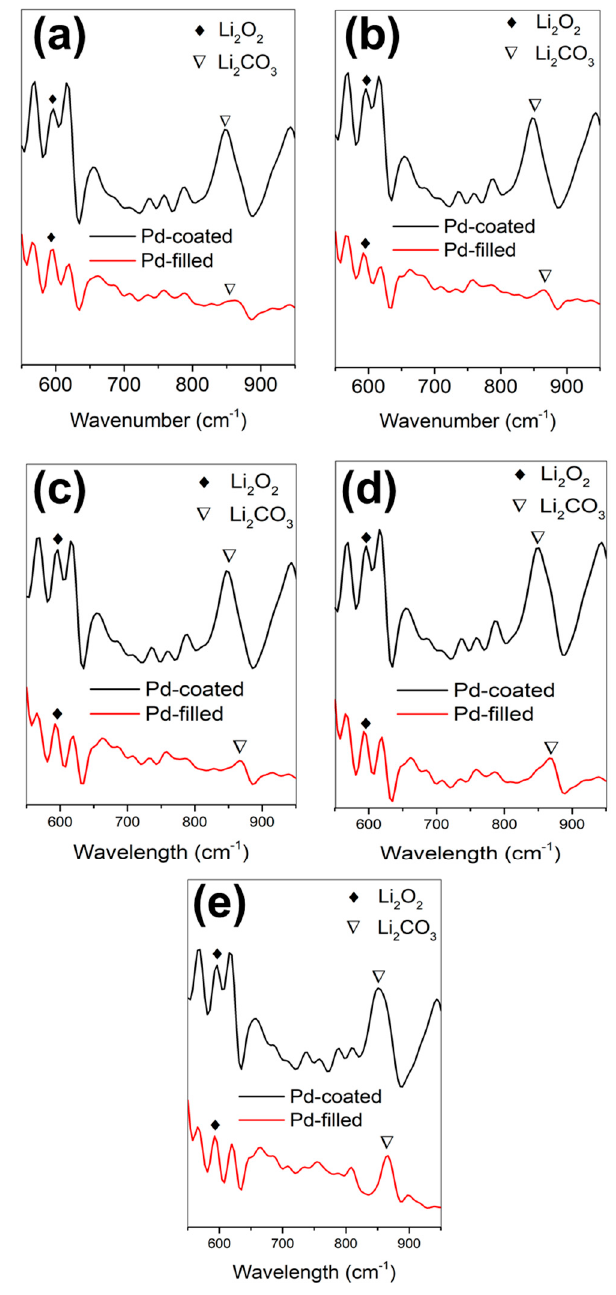
Figure 6. FTIR spectra after discharging to ( a ) 500 mAh.g − 1 , ( b ) 1000 mAh.g − 1 , ( c ) 1500 mAh.g − 1 , ( d ) 5000 mAh.g − 1 , and ( e ) 8000 mAh.g − 1 . All batteries were discharged at 250 mA.g − 1 between 2 to 4.5 V.